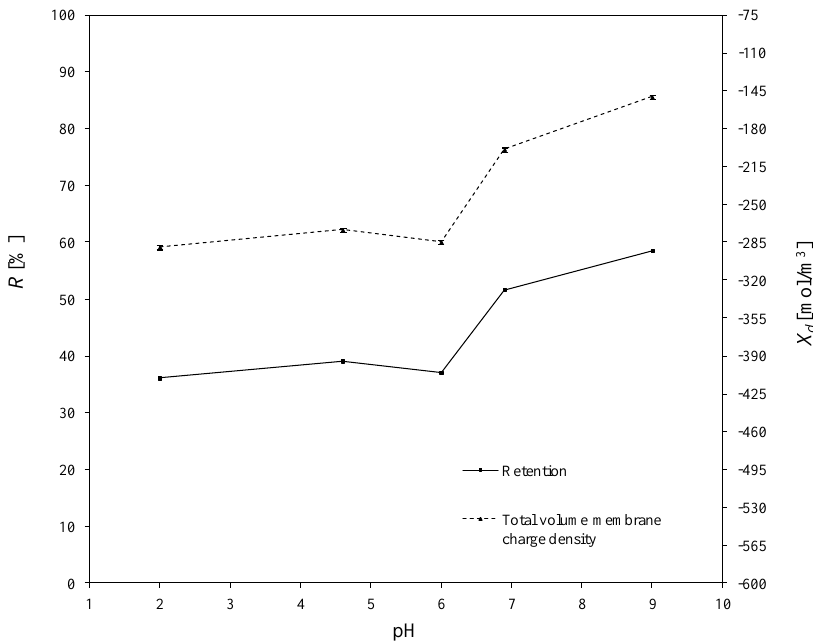
Figure 6. The influence of pH on the total volume charge density in aqueous solution of Zn(NO 3 ) 2 and the influence of pH on the (Zn 2+ ) retention. Retention values obtained experiments.